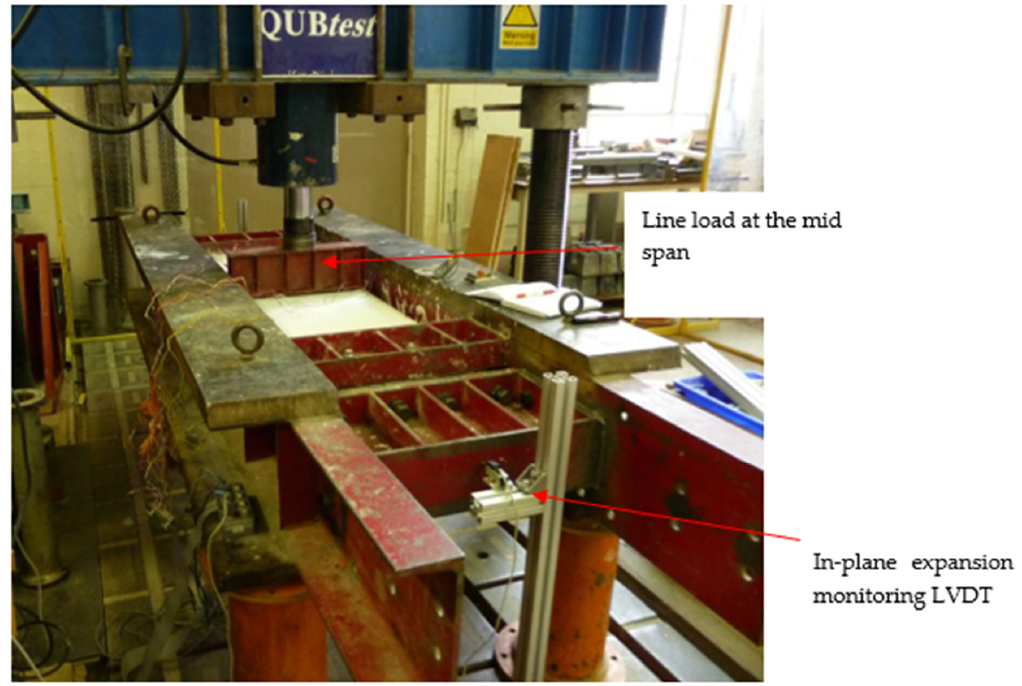
Figure 1. Test load arrangement of the slabs.